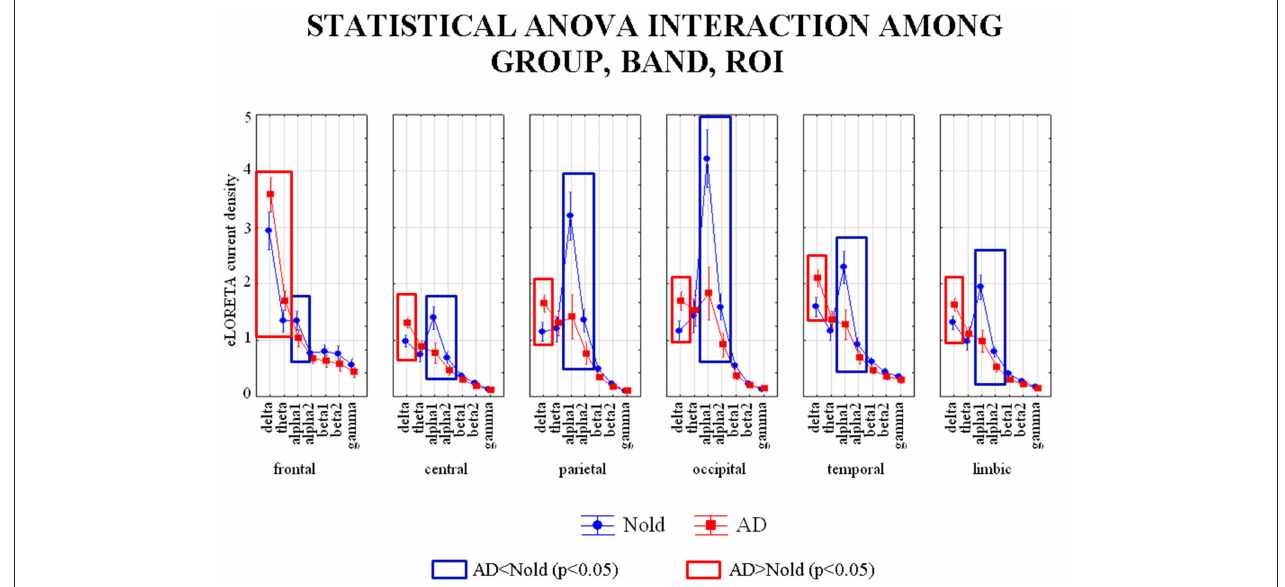
FIGURE 2 | Diagram showing the grand average of regional normalized exact low-resolution brain electromagnetic tomography (eLORETA) solutions (i.e., source activity) relative to a statistically significant ANOVA interaction [ F (30 , 6540) = 18.727 , p < 0.0001] among the factors Group (AD, Nold), Band (delta, theta, alpha 1, alpha 2, beta 1, beta 2, gamma), and ROI (central, frontal, parietal, occipital, temporal, limbic). Subjects’ age, education, IAF, and gender were used as covariates. Legend: the rectangles indicate the cortical regions and frequency bands in which source activity presented the statistically significant LORETA pattern of source activity Nold 6= AD (Duncan test, p < 0.05).